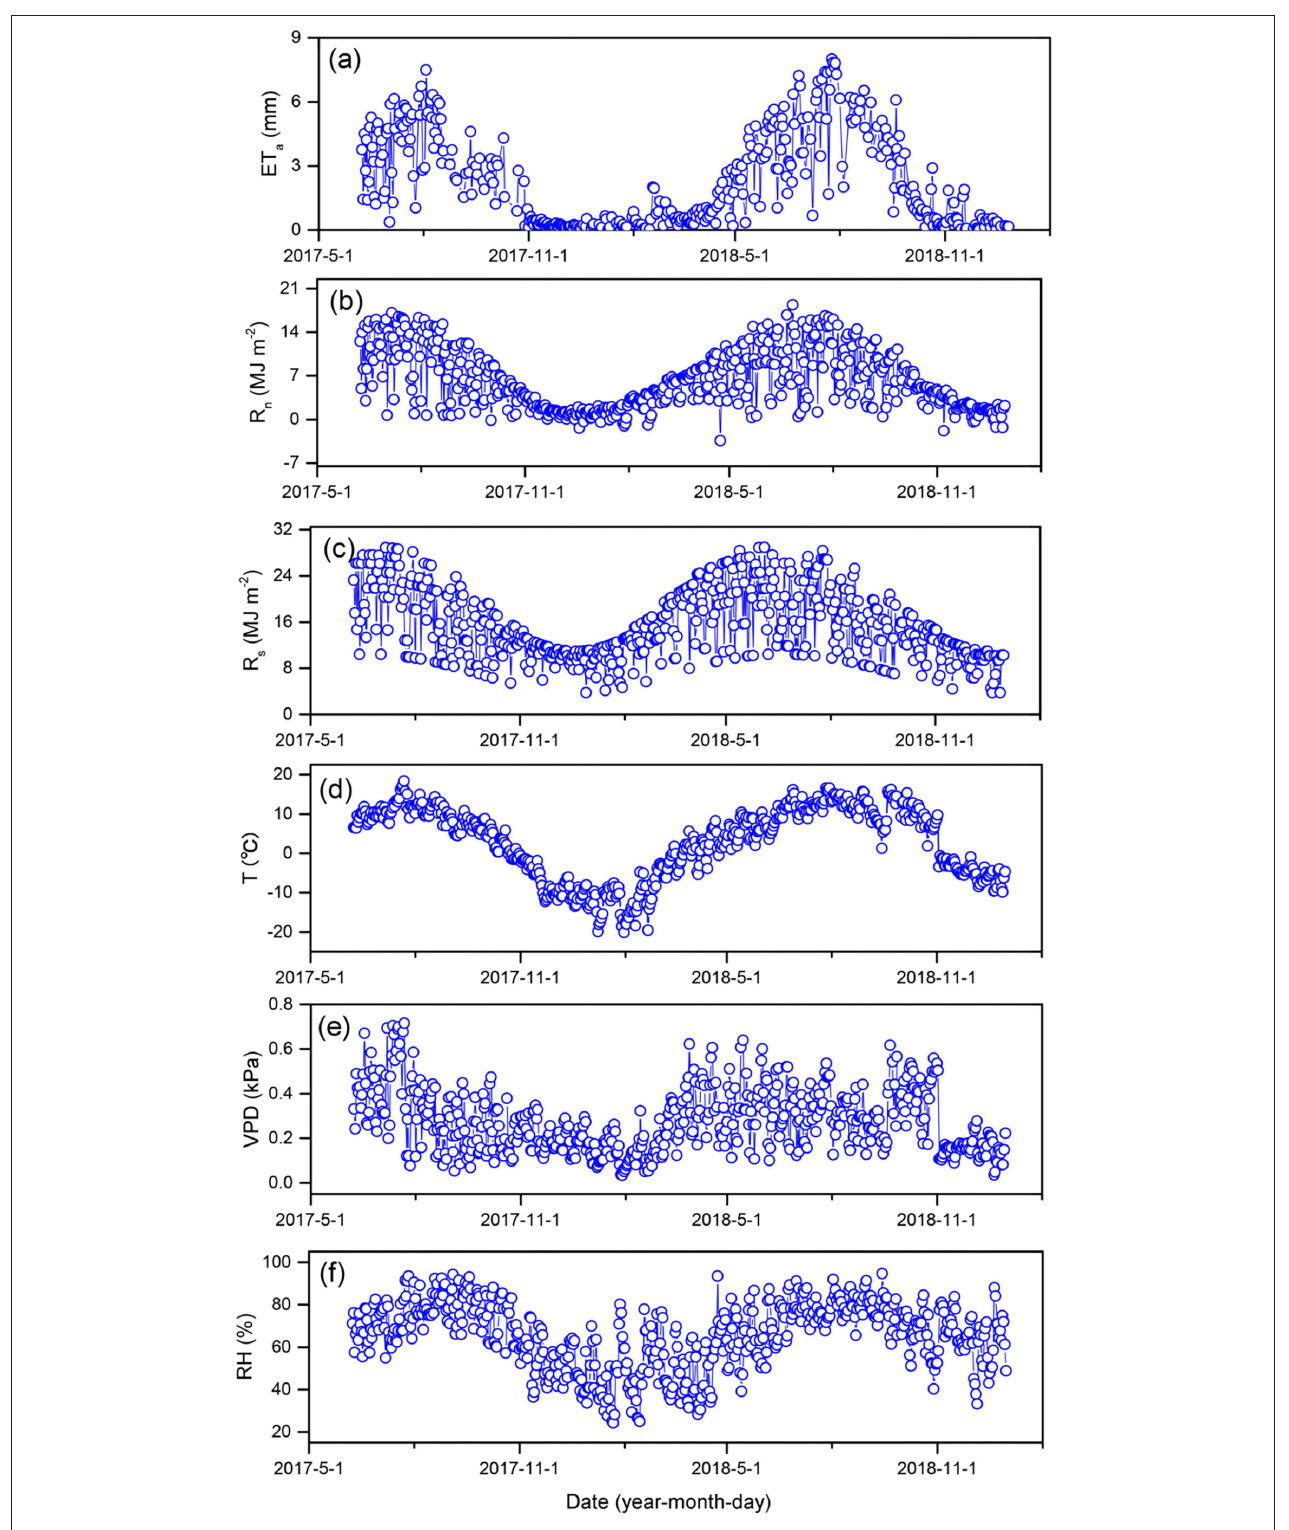
FIGURE 2 | Seasonal variation of actual evapotranspiration (ET a ) (a) , net radiation (R n ) (b) , total radiation (R s ) (c) , mean air temperature (T) (d) , vapor pressure deficit (VPD) (e) , and relatively humid (RH) (f) .